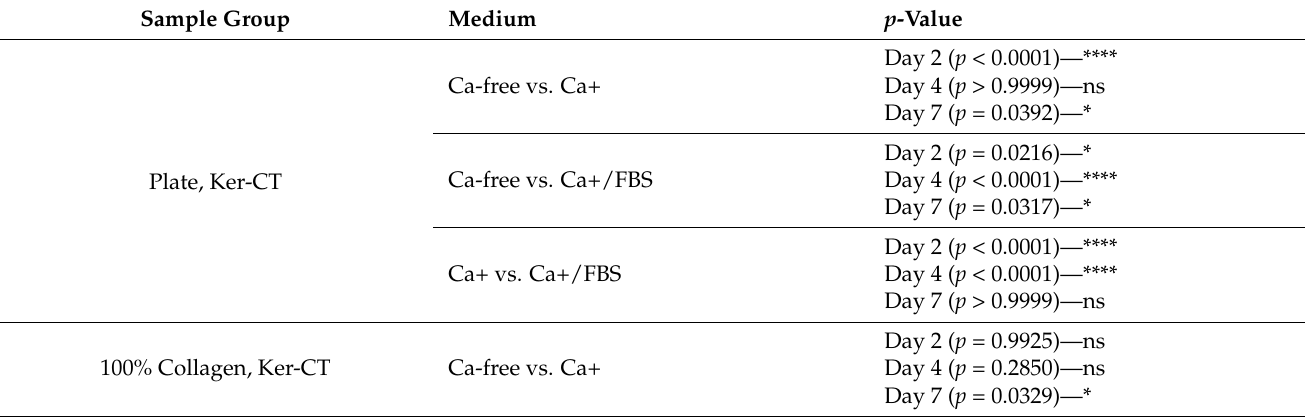
Table 2. Comparison of GBA activity between different media within each sample group. GBA activity was normalized to cell viability. For most samples, especially for primary NHEKs, addi- tion of in c calcium increased the GBA activity; addition of FBS also further increased the GBA ac- tivity. Two-way ANOVA was performed with n = 4 with 3 separate experiments. * = p < 0.05, ** = p < 0.01, *** = p < 0.001, **** = p < 0.0001, ns = not significant.